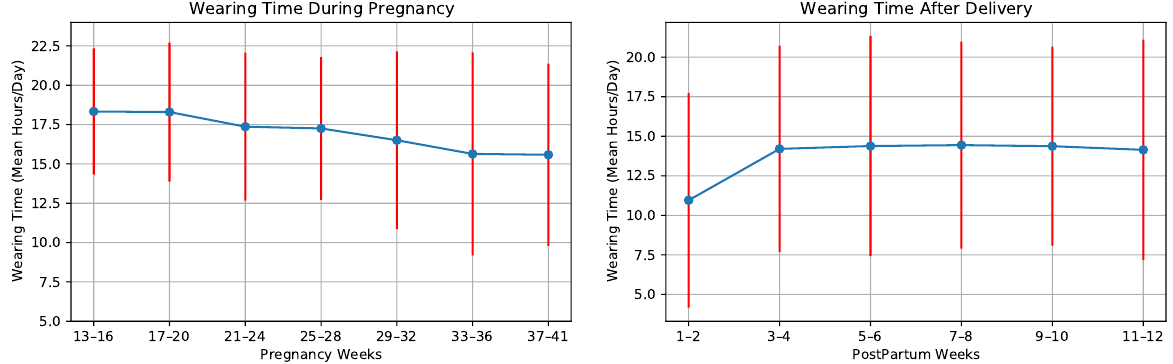
Figure 6. Smartwatch wearing time during pregnancy and postpartum of the 28 high-risk pregnant